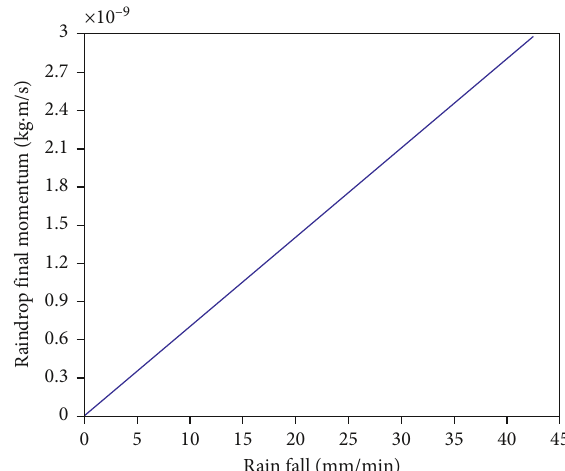
Figure 6: Relationship between precipitation and raindrop momentum.